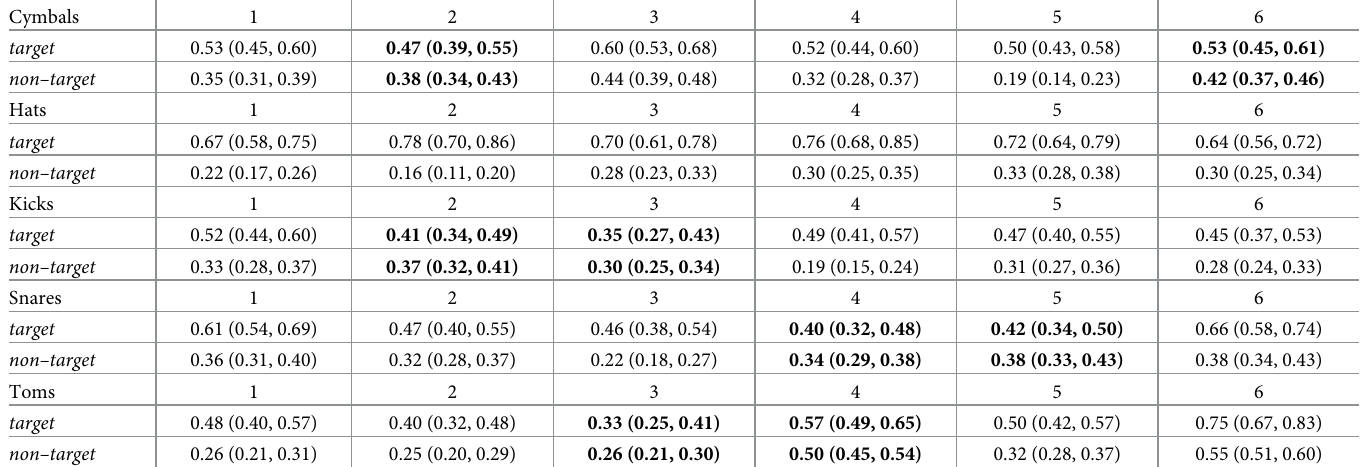
Table 2. Comparison of similarity ratings between imitations and target vs. non–target sounds, by drum sound. Values are mean rating parameter estimates with 95% Wald confidence intervals (CIs). Cases where the CIs overlap between conditions for each drum sound are given in bold.